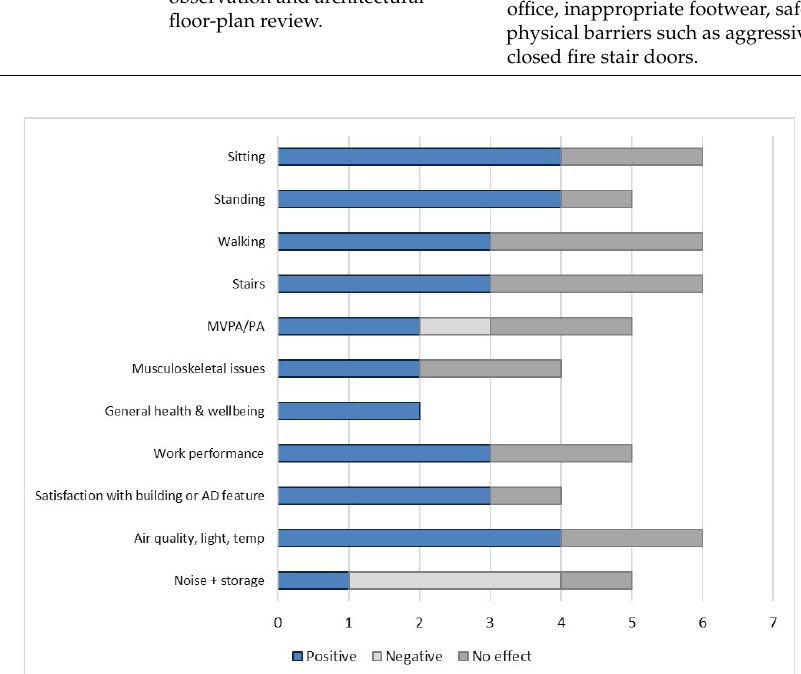
Figure 3. Summary of the number of studies that found a positive, negative or no effect on an outcome in the active design building. Sample size or the quality of the study have not been taken into consideration.